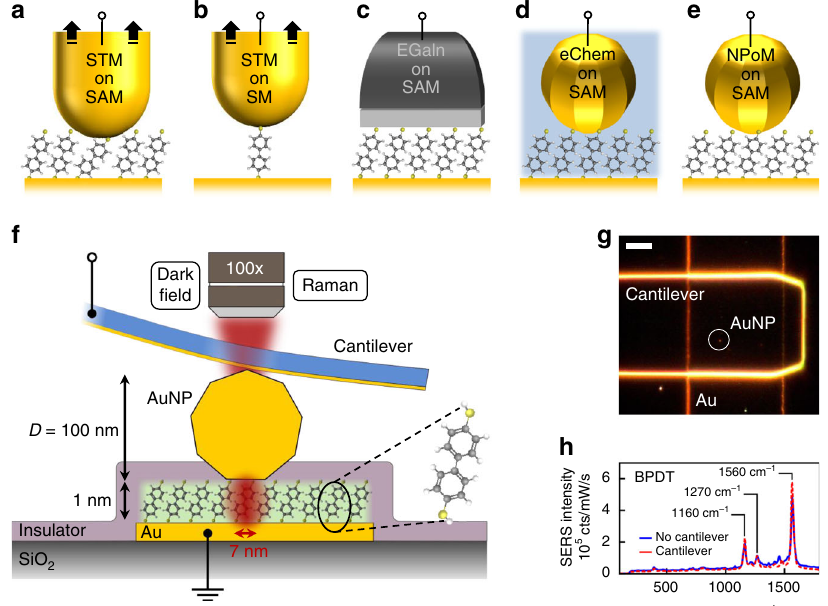
Fig. 1 Schemes for contacting molecular junctions. a , b Junctions formed by scanning tunnelling microscope (STM) tip pull-off from a SAMs or b single molecules. c Eutectic GaIn alloy contacts. d Large area electrochemical cells indirectly contact AuNPs on SAMs and e scheme here using single plasmonic nanoparticle contact. f , g Detail of Au nanoparticle on SAM (NPoM geometry) which is electrically contacted by a conductive transparent cantilever, giving real-time optical access to the junction. Scale bar in g is 10 µ m. h Raman spectroscopy of BPDT molecular layer in NPoM through the cantilever shows molecules are unperturbed. Laser power at sample is 0.2 mW, λ = 633 nm, focussed to sub- μ m